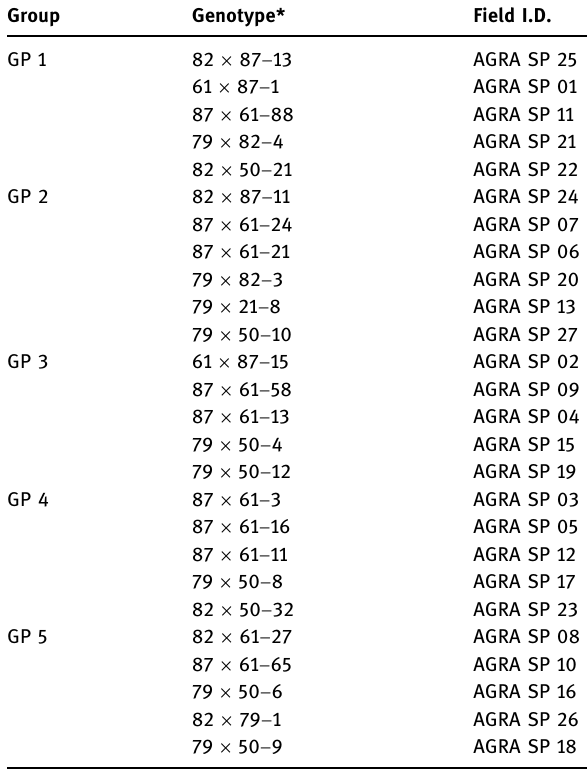
Table 1: The 26 F 1 s selected from the ABS and used for the multilocational on - farm evaluation using mother – baby trial